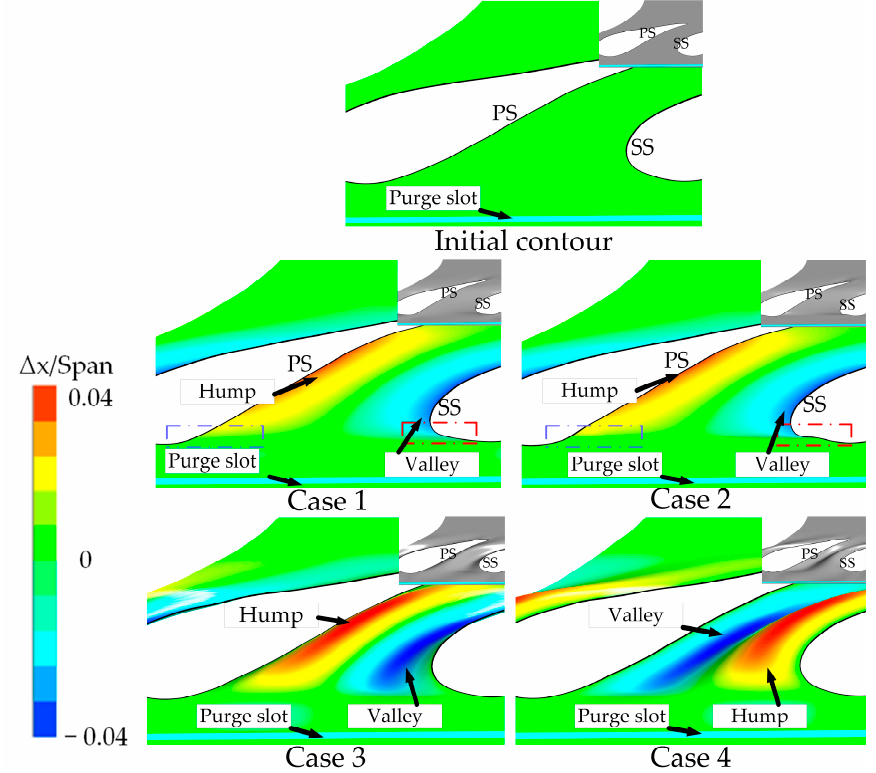
Figure 5. Contoured endwall height distribution.